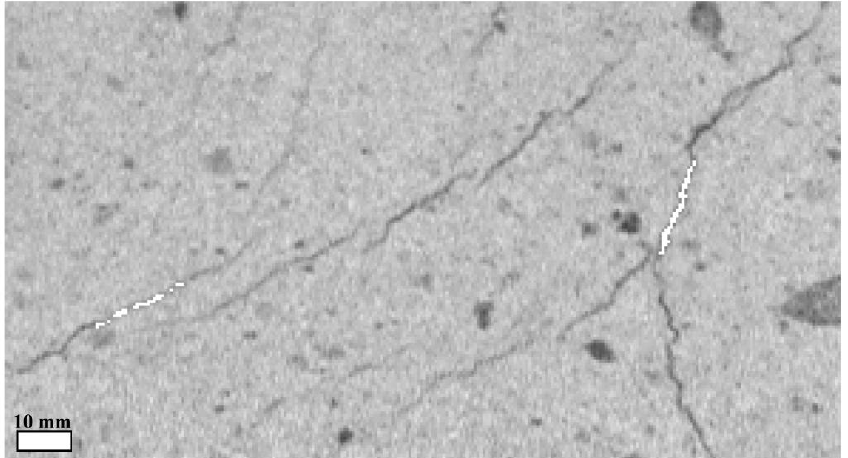
Figure 8. Cracks detection results (white regions) without restriction on the investigation box. Image located at mid width of the anode slice. Left crack: near stub hole. Right crack: near anode slot.